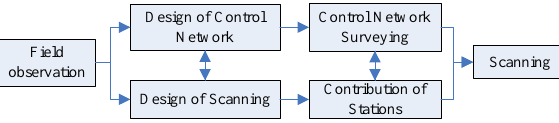
Figure3 Scanning Process of Large Steel structure